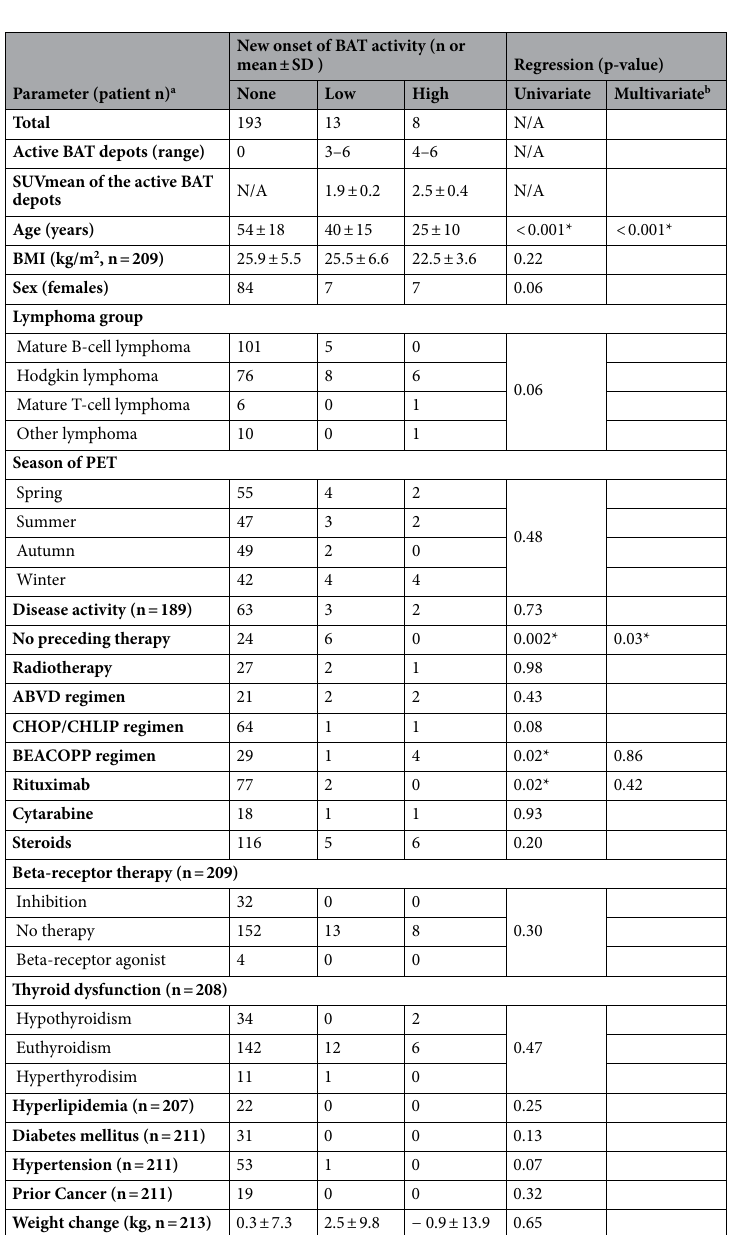
Table 3. Distribution of the study parameters in PET/CT examinations of prior BAT negative patients (n = 214) depending on the BAT activity. *Significant, p value of < 0.05, a patient number for evaluation of this parameter if divergent from the total patient number, b only significant parameters of the univariate analyses were included. BAT brown adipose tissue, SUVmean mean standardized uptake value, ABVD regimen doxorubicin, bleomycin, vinblastine, dacarbazine, CHOP/CHLIP regimen cyclophosphamide, doxorubicin, conventional/liposomal vincristine, steroids, BEACOPP regimen bleomycin, etoposide, doxorubicin, cyclophosphamide, vincristine, procarbazine and steroids, N/A not